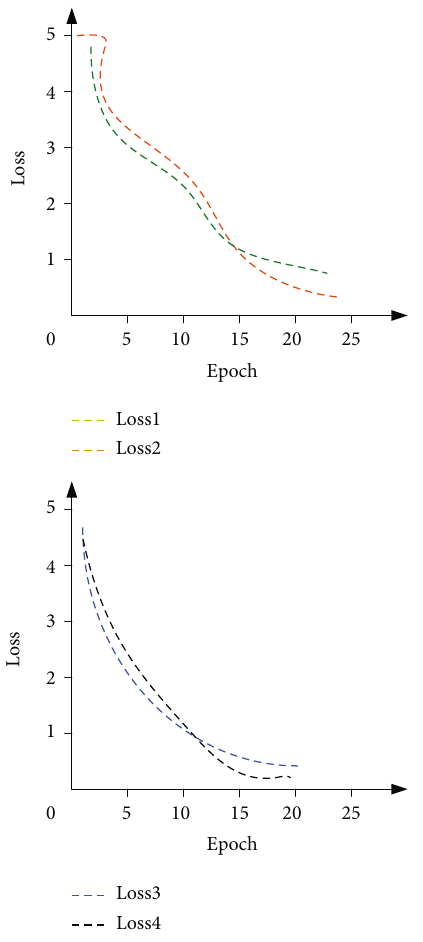
Figure 9: Image information loss